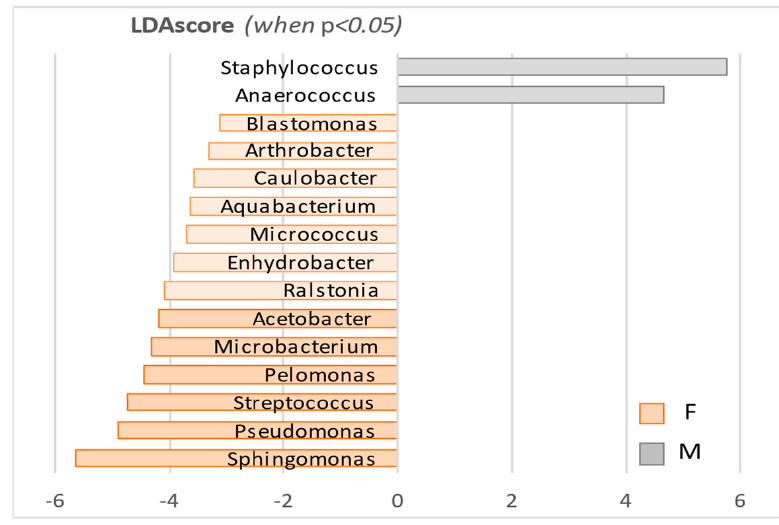
Figure 7. Graphical representation of results obtained by the LefSe analysis, at genus level.